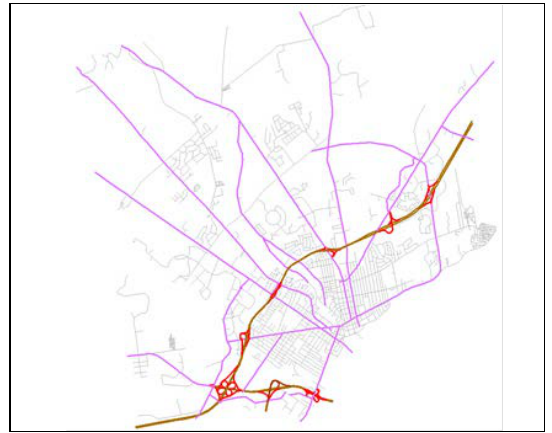
Figure 12. Experiment result of road network structures Data source: City of Bangor, Maine, USA As was discussed in 3.2 that the spatial reasoning embedded in the proposed method is able to discover data errors or to derive new knowledge, the result in Figure 13 would support the point.